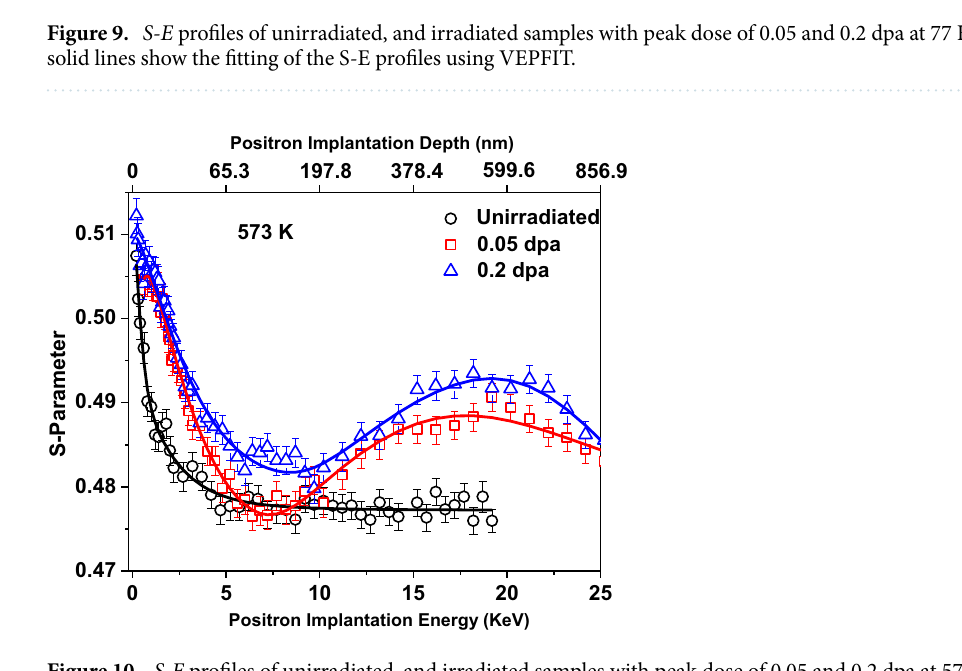
Figure 10. S-E profiles of unirradiated, and irradiated samples with peak dose of 0.05 and 0.2 dpa at 573 K. The solid lines show the fitting of the S-E profiles using